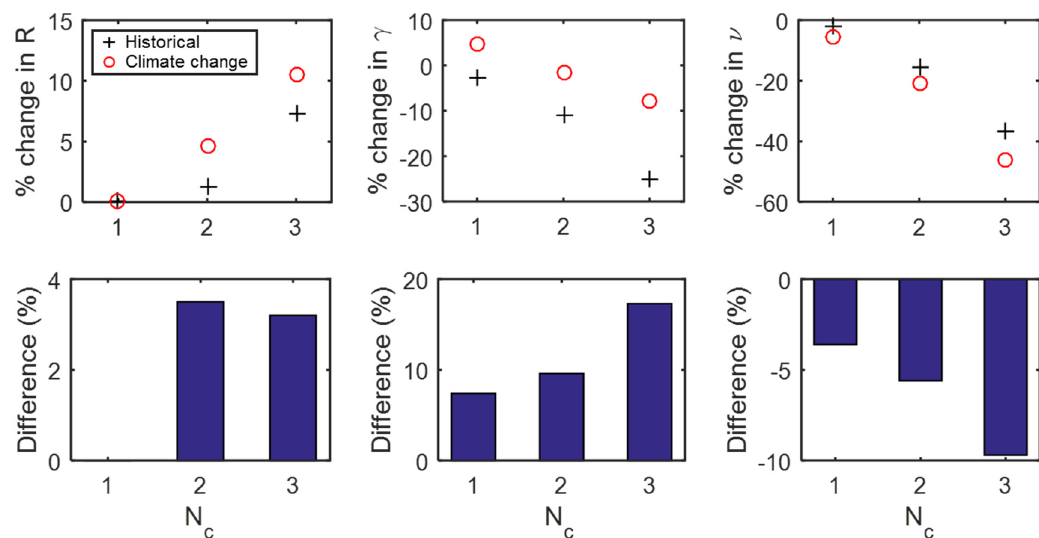
Figure 11. Comparison of the benefits from the sharing network in terms of